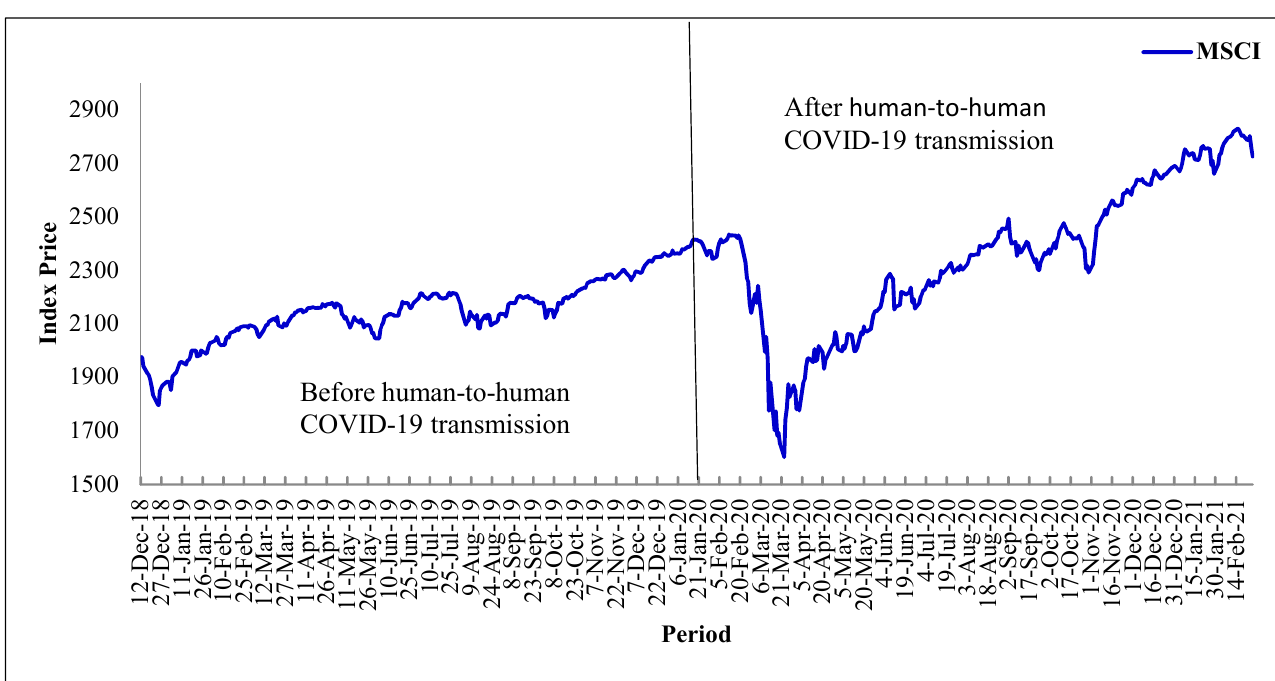
Figure 2. Daily movements of the Baltic Exchange dry index (BDI).